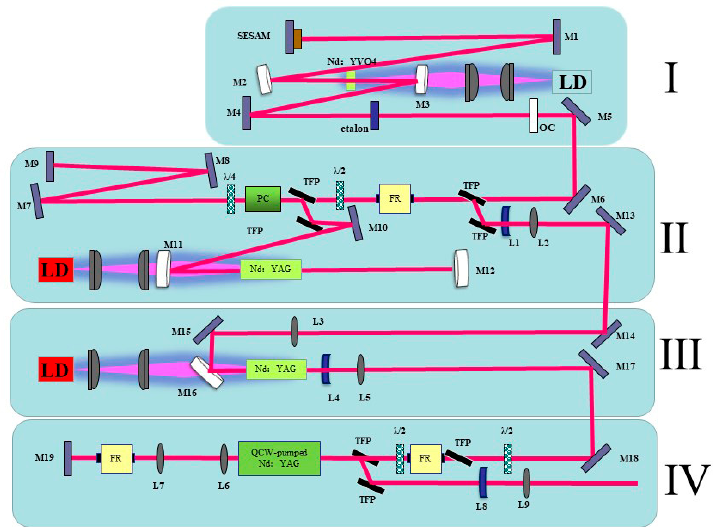
Figure 1. The scheme of picosecond laser system. I, Nd:YVO 4 oscillator; II, regenerative amplifier; III, end-pumped amplifier; IV, side-pumped amplifier.